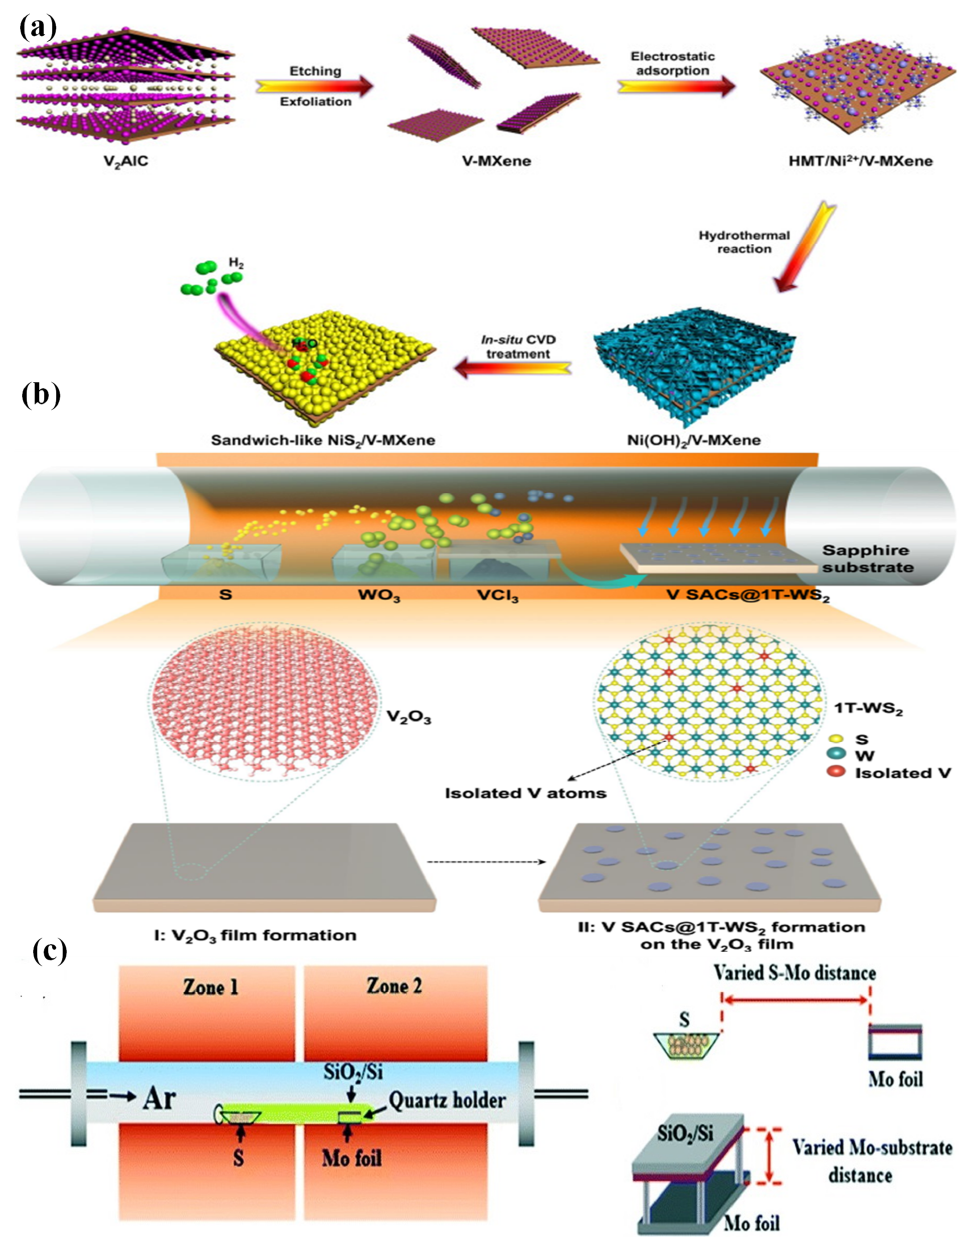
Figure 4 . ( a ) Schematic illustration of the synthetic of NiS 2 /V-MXene hybrid by using combination of HF etching, ultrasonic exfoliation, electrostatic adsorption, hydrothermal and in situ CVD processes [44]; ( b ) formation of V SACs@1T-WS 2 monolayers on the V 2 O 3 film through a one-step CVD method by controlling the introduction of VCl 3 co-precursor [47]; ( c ) employment of fabrication equipment and the space-confined growth during the CVD synthesis of MoS 2 samples [48].